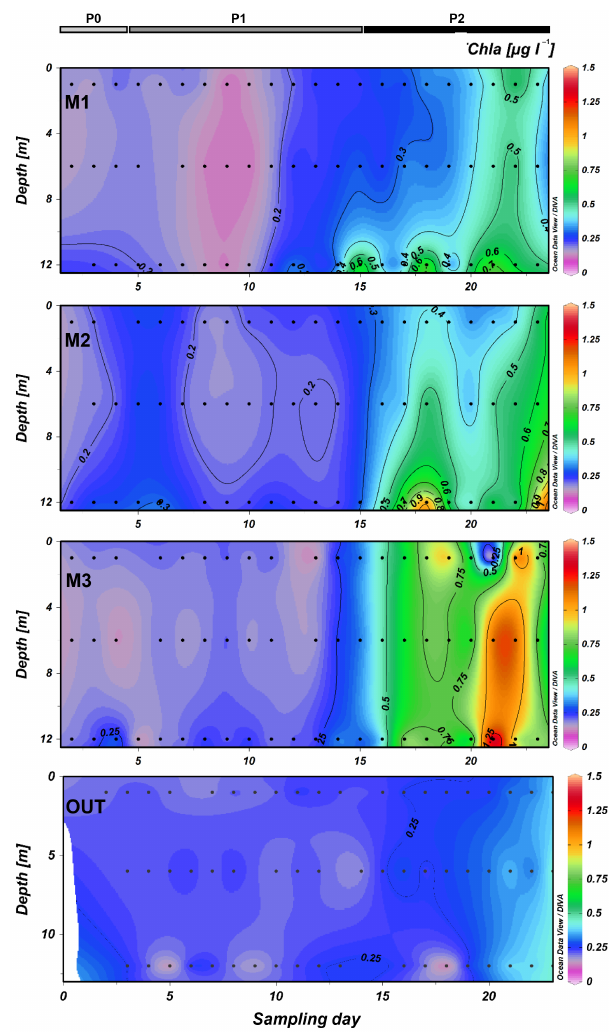
Figure 2. Total Chl a in µgL − 1 at each of the three depths (1, 6 and 12m) inside each mesocosm (M1, M2 and M3) and outside of mesocosms